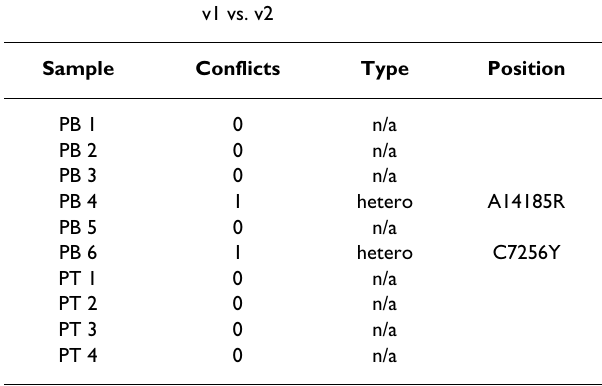
Table 5: Version1 vs Version 2 Arrays v1 vs. v2